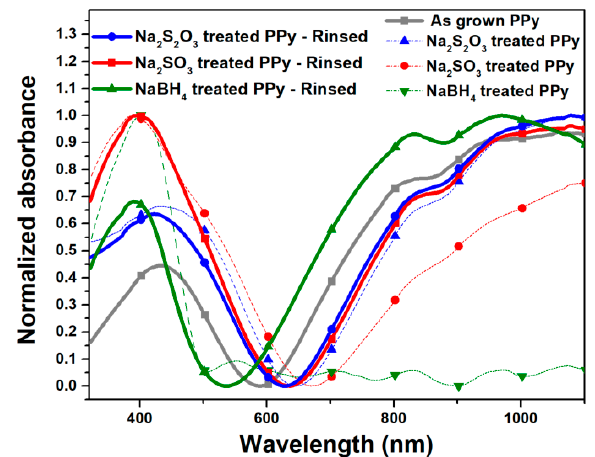
Figure 6. UV–Vis–NIR spectra of PPy grown by VPP on glass substrate. Measurements were performed after reduction treatments in Na 2 S 2 O 3, Na 2 SO 3 and NaBH 4 10 wt% solution in demineralized water followed by rinsing in demineralized water.